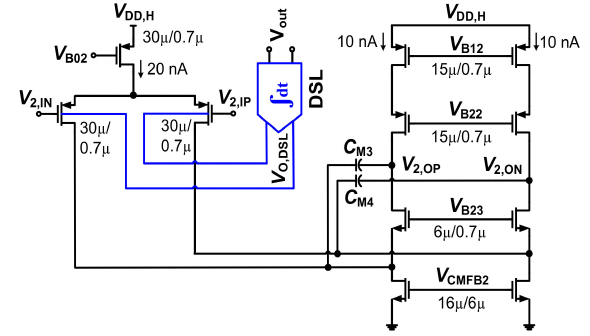
Figure 6. Schematic of transconductor G m2 with body-controlled DSL. C M3,4 = 0.5 pF. V B02 = V B12 =